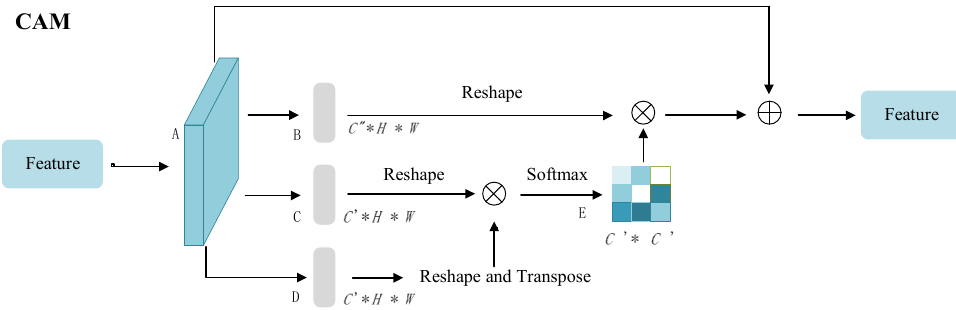
Figure 7. The structure of the CAM. B = value feature maps, of which dimension is C’’*H*W , C = query feature maps, of which dimension is C’*H*W , D = key feature maps, of which dimension is C’*H*W .